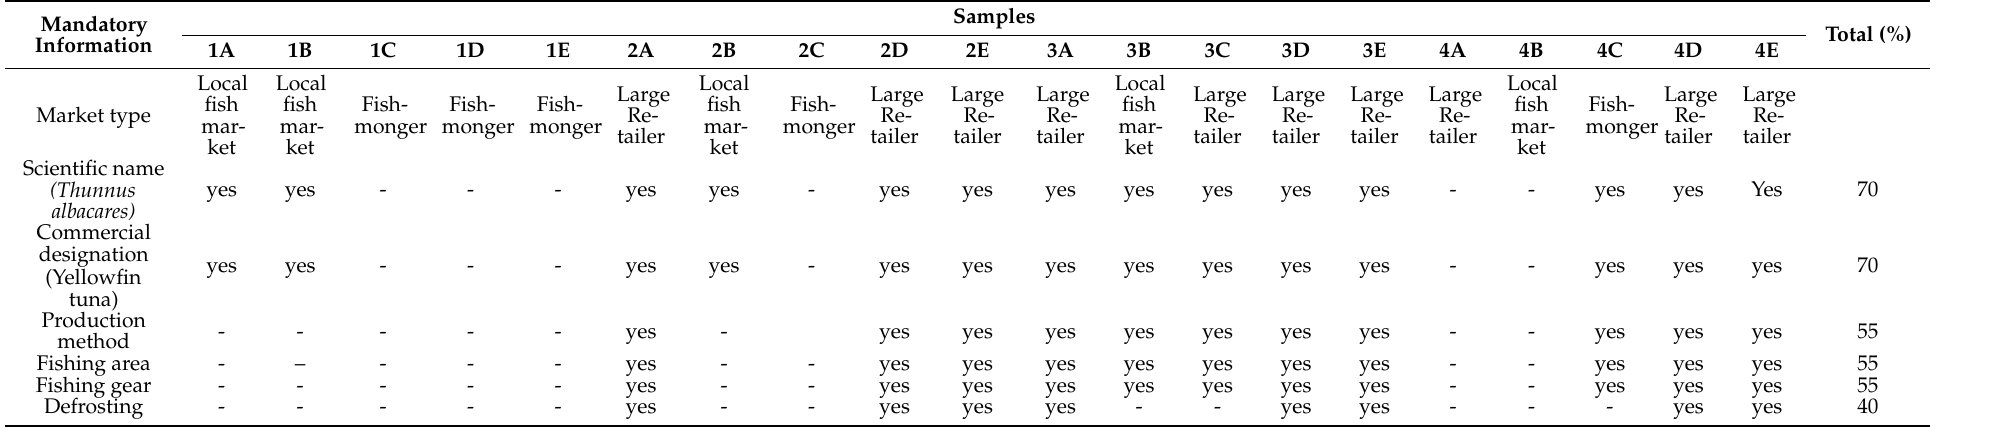
Table 4. Labelling of yellowfin tuna samples included in the study.